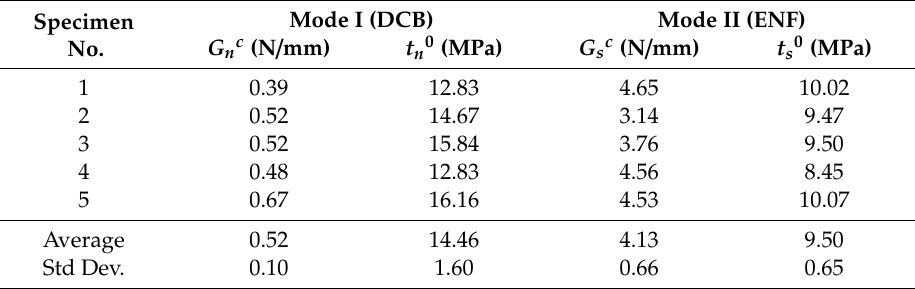
Table 2. Mode I and II cohesive parameters extracted from DCB and ENF tests.